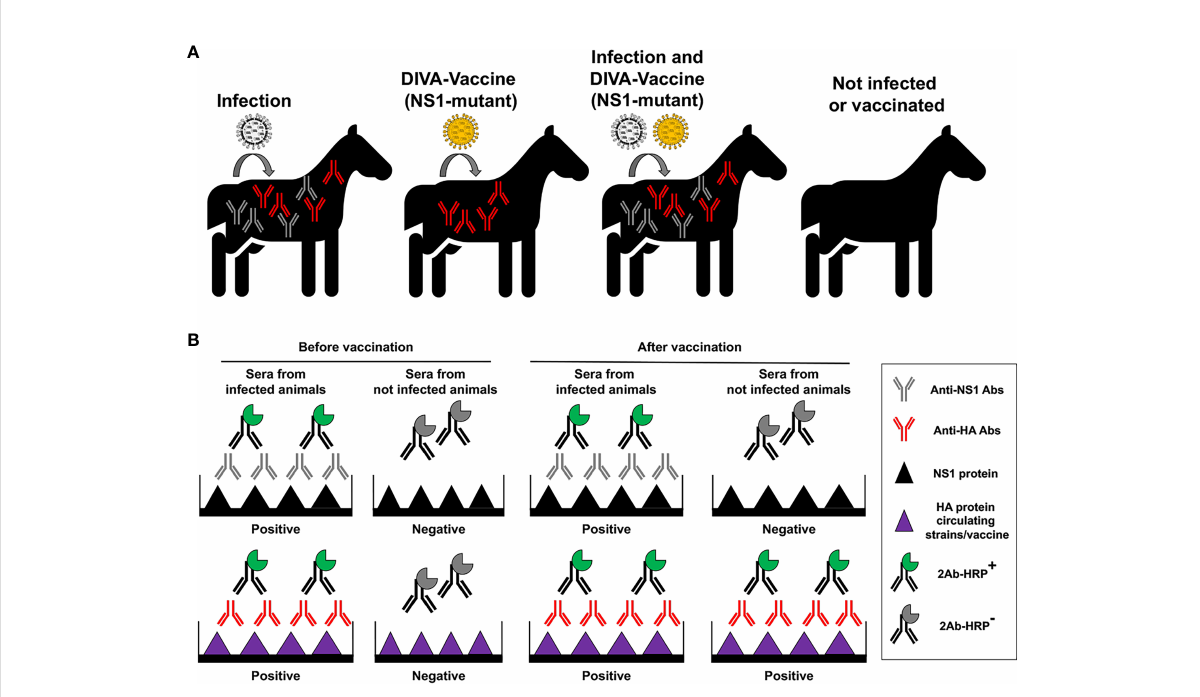
FIGURE 7 Principle of vaccination with NS1 truncated or de fi cient viruses as DIVA LAIV. (A) Speci fi c antibodies (Abs) against IAV NS1 protein will be produced in infected animals, but not in animals vaccinated with NS1 truncated or de fi cient IAV (DIVA vaccine). However, speci fi c antibodies against viral HA from circulating strains or the vaccine will be induced in infected and/or vaccinated animals, respectively. (B) Development of a DIVA serological test. Abs against IAV NS1 induced by natural infection can be identi fi ed by proper serological tests. In the fi gure an ELISA is used to differentiate sera from infected (containing antibodies against both NS1 and HA proteins) and not infected animals, before vaccination. Wells are coated using recombinant NS1 or HA IAV proteins. Then, the same serological test is carried out after vaccination to differentiate animals that has been infected from animals that have been not infected. Samples from infected animals will be positive for HA and NS1 in the ELISA tests, while samples from vaccinated and not infected animals will be positive only for HA in the ELISA